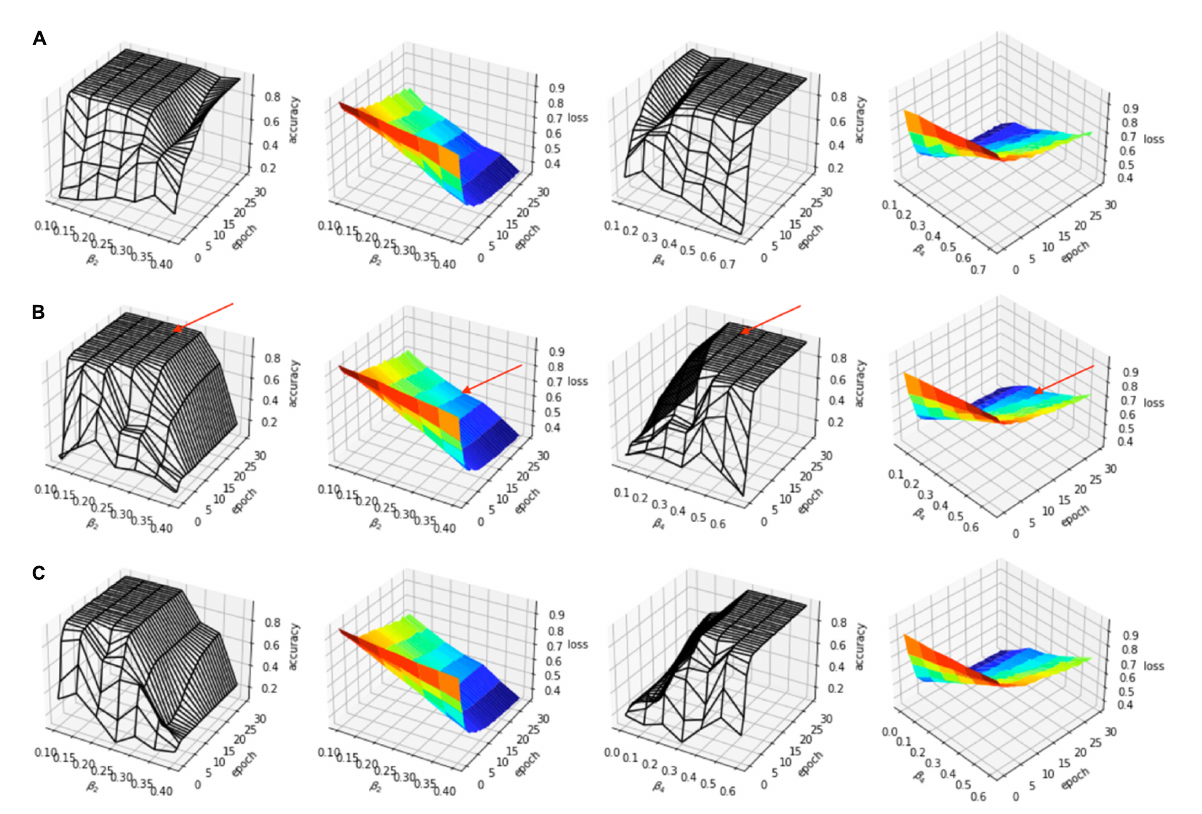
FIGURE7 Simulation experiment for (A) β 1 = 0 . 1, (B) β 1 = 0 . 15, and (C) β 1 = 0 . 2. In each case, β 2 = β 3 . The arrows in (B) indicate the choice (